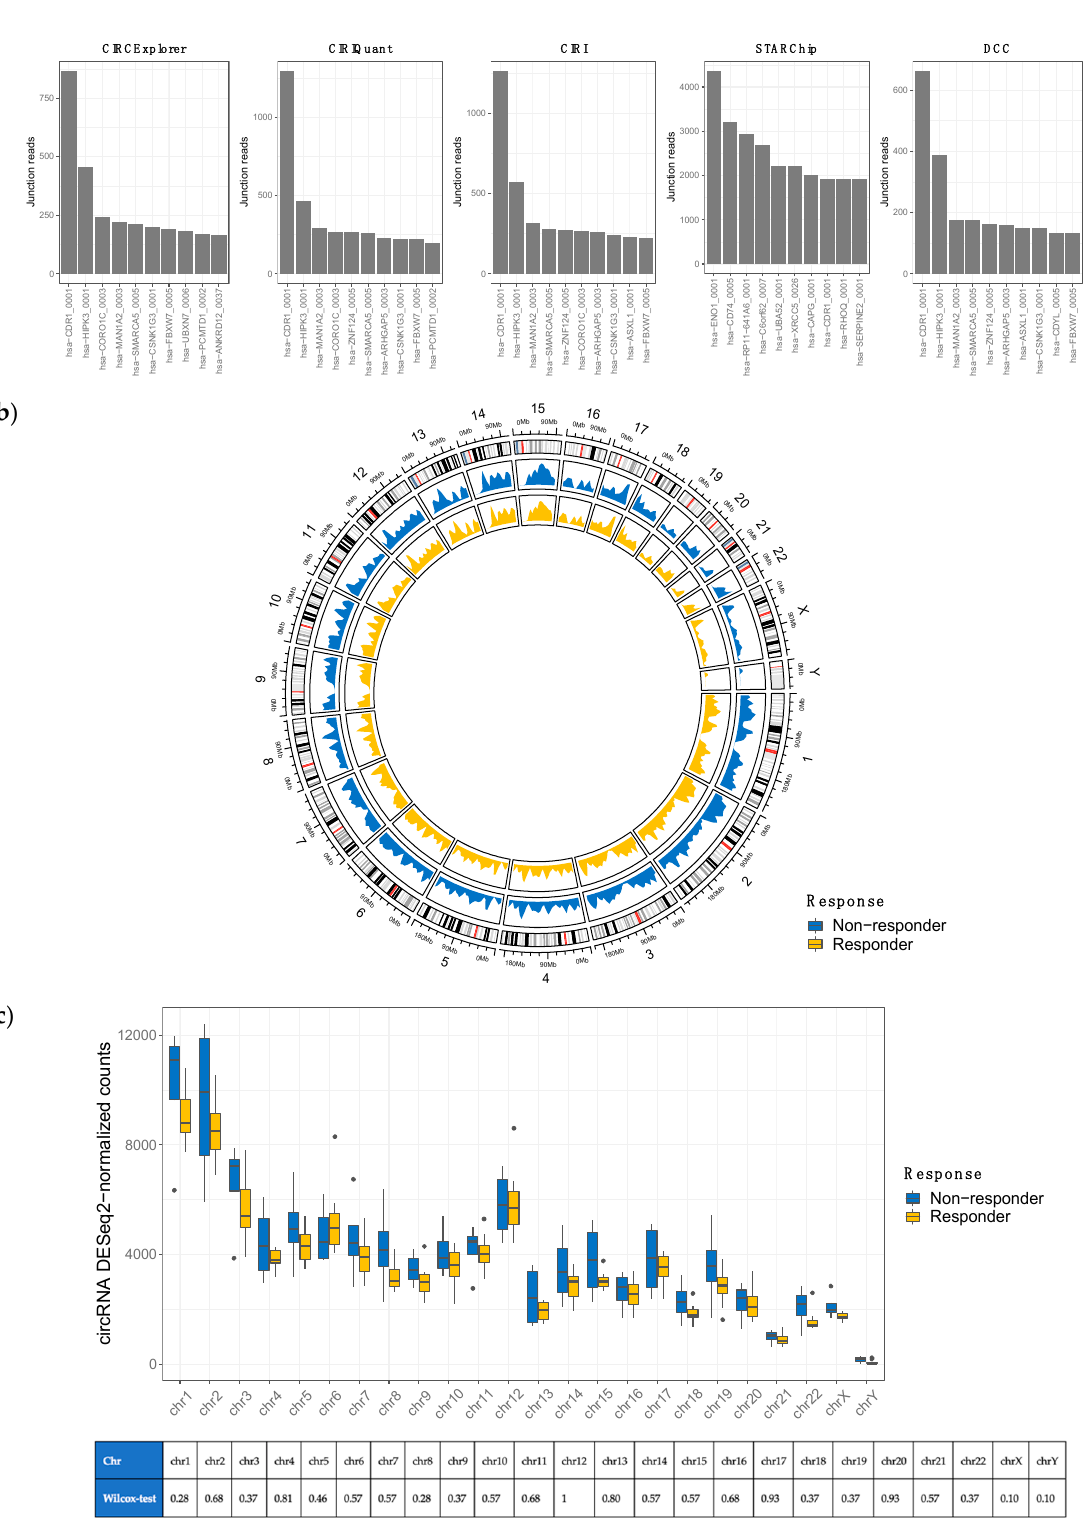
action network. The pipeline is depicted from the RNA-seq fastq files to the ingenuity pathway analysis. Five different software packages were employed to identify circRNAs. mRNAs affected by ceRNAs were predicted by their interaction with miRNA. Differential expression analysis with DESeQ2 was used to decipher differences in responses to immunotherapy. ( b ) Venn diagram with the number of different cirRNAs detected by each software. ( c ) UpSet plot showing the maximum number of identified circRNAs with each software combination .